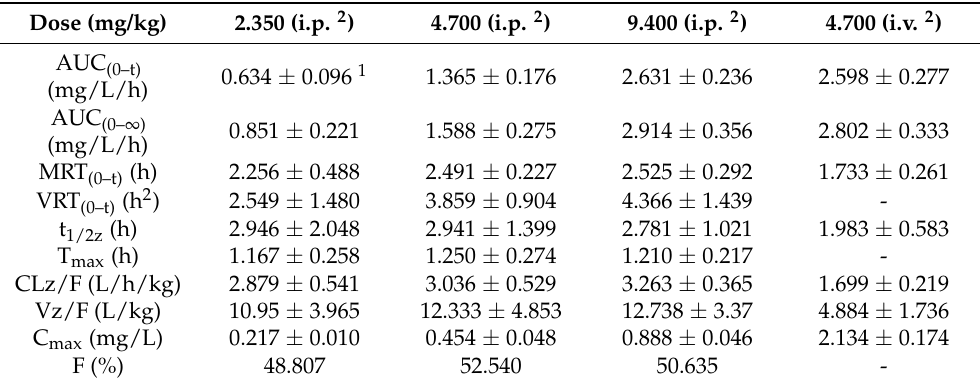
Table 3. Pharmacokinetic parameters of